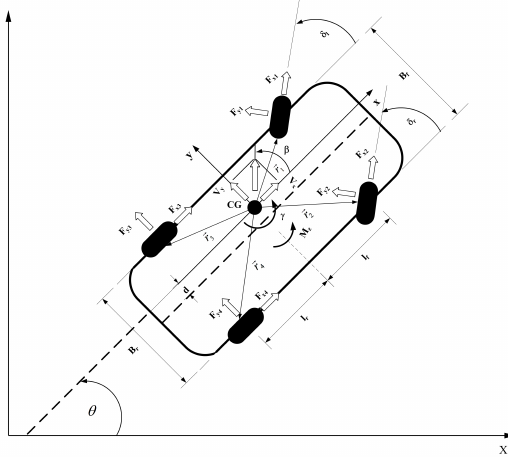
Fig. 1: 7-DOF vehicle